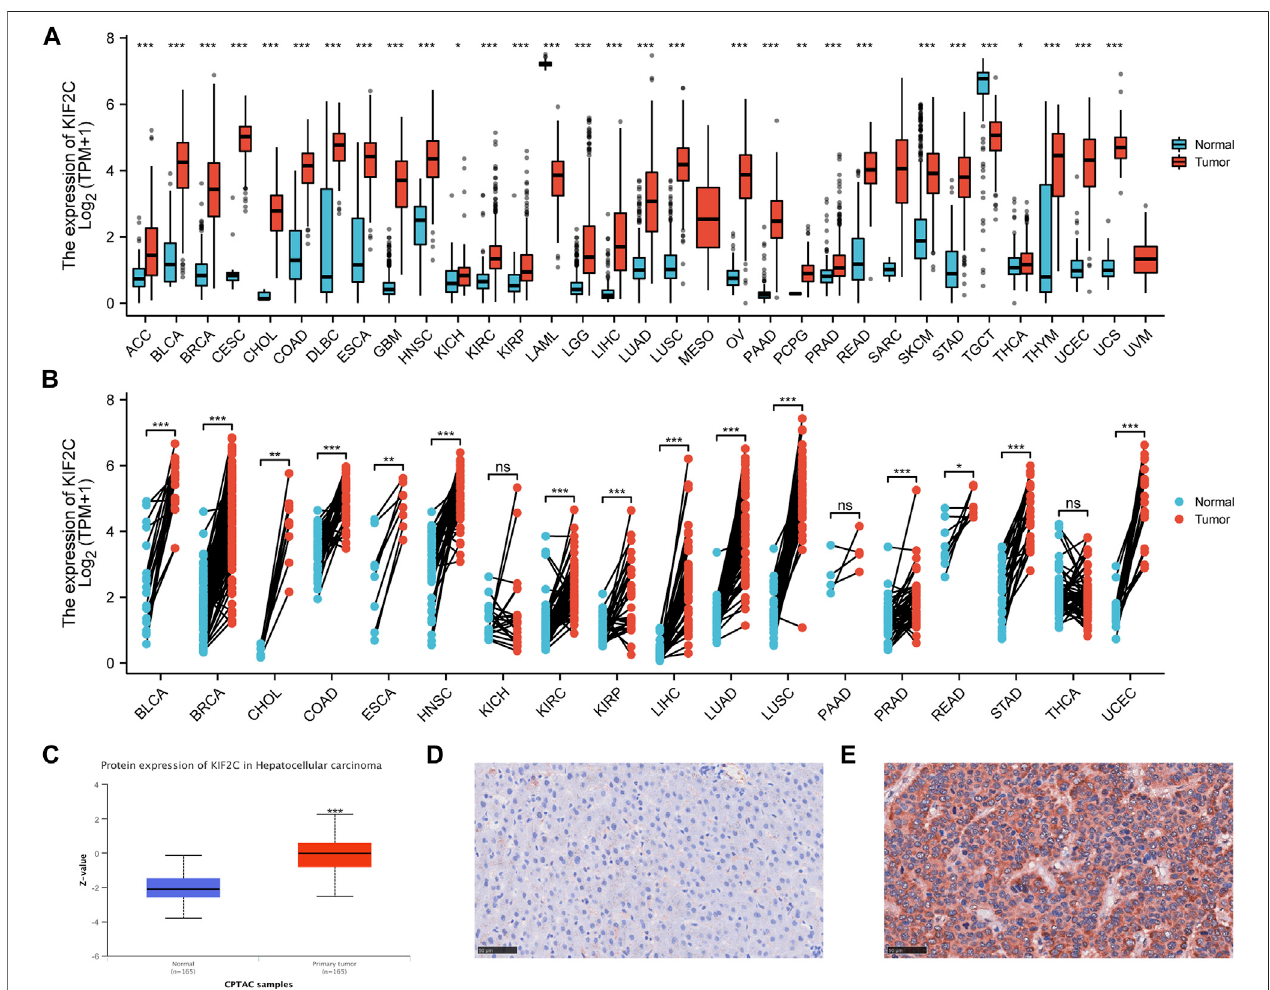
FIGURE 1 | Pan-cancer KIF2C expression analysis (A) KIF2C expression levels in pan-cancer from TGCA and GTEx (B) Expression levels of KIF2C in paired samples (C) KIF2CproteinlevelinhepatocellularcarcinomawasexaminedusingtheCPTACdataset. (D) LowexpressionofKIF2Cinnormaltissues. (E) Highexpression of KIF2C in liver cancer tissues. * p < 0.05, ** p < 0.01, *** p <